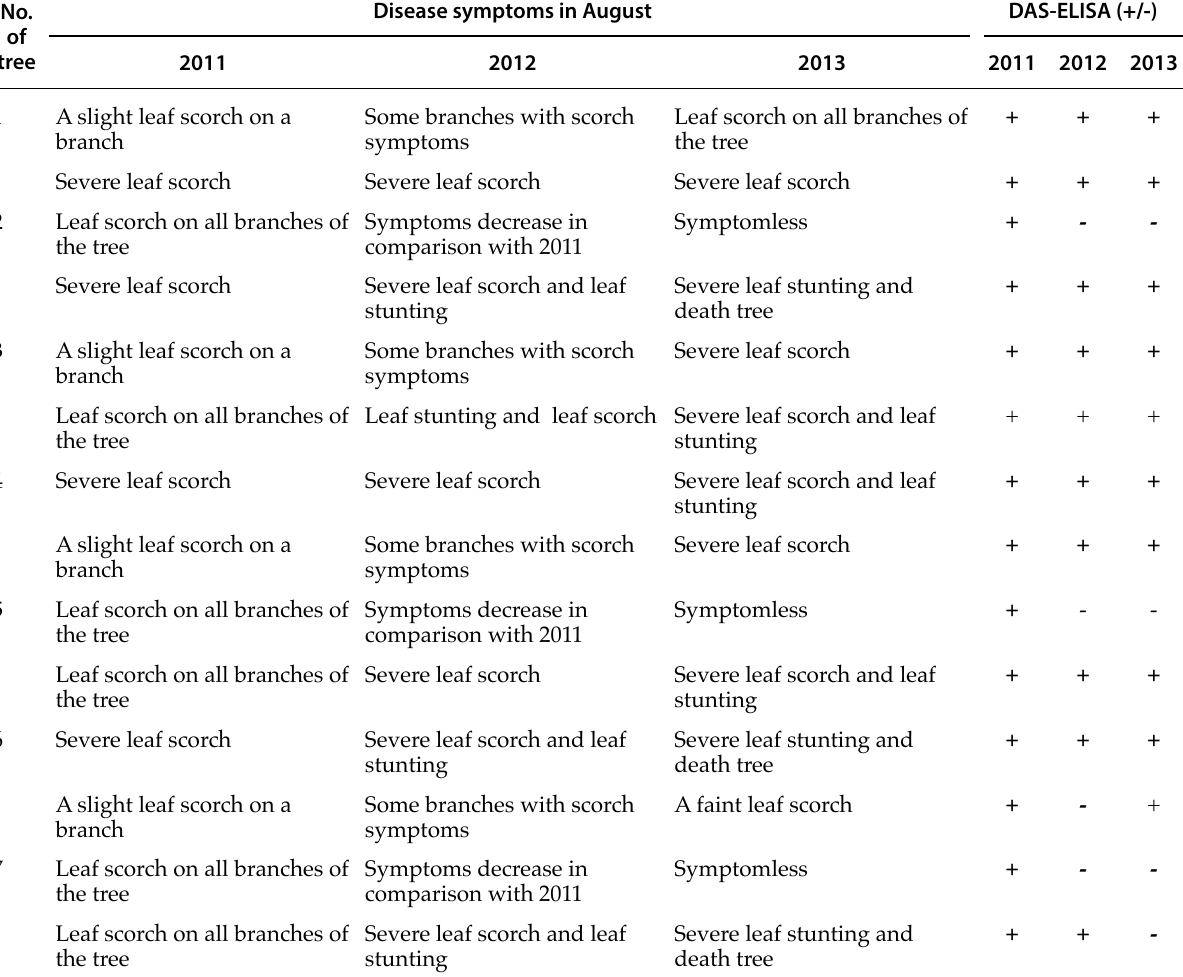
Table 1. Almond leaf scorch disease progressing in seven trees (cv. Mamaee), under orchard conditions along the Zayan- derood River and Ardal region in southwestern Iran during 2011-13. DAS ELISA assay results for sampled plant tissues are also